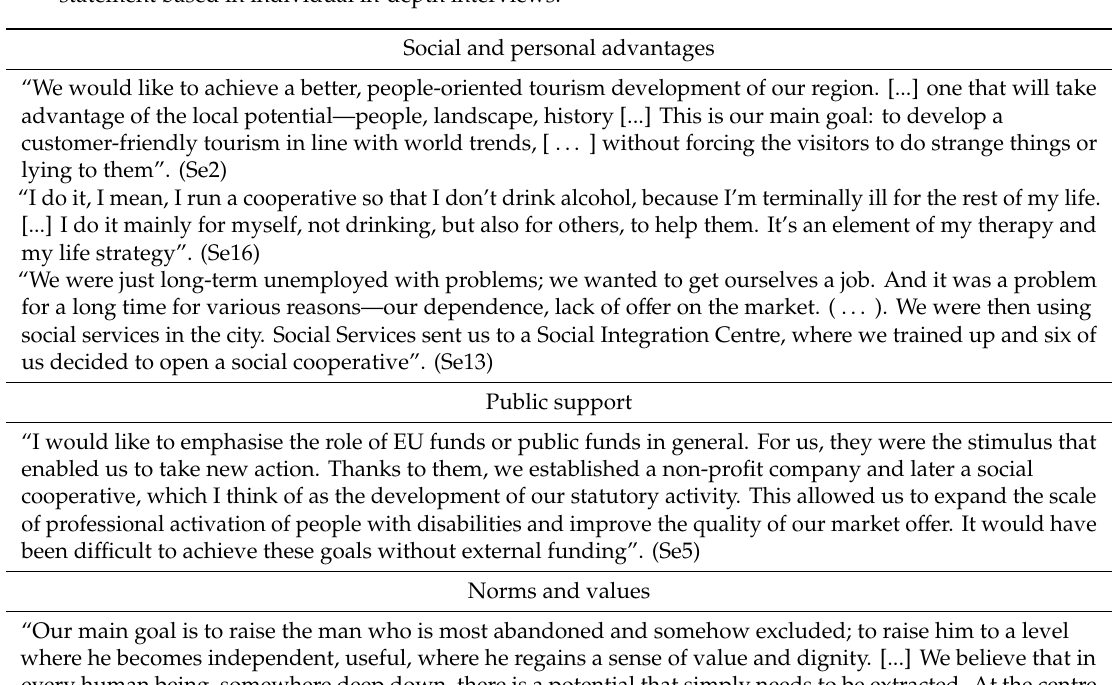
Table 2. Involvement in social enterprises in opinion of social entrepreneurs—selected respondent statement based in individual in-depth